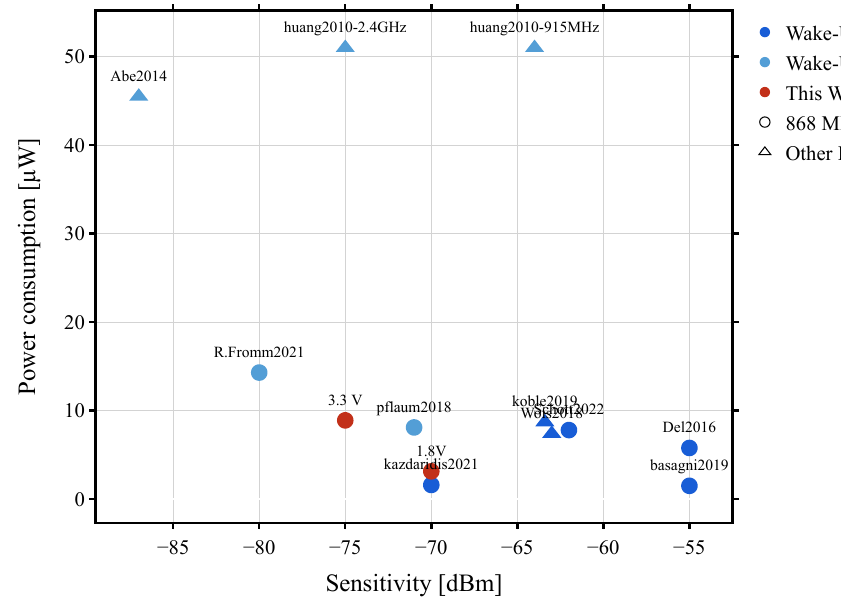
Figure 22. Comparison of the effect of LNA integration with SoA of